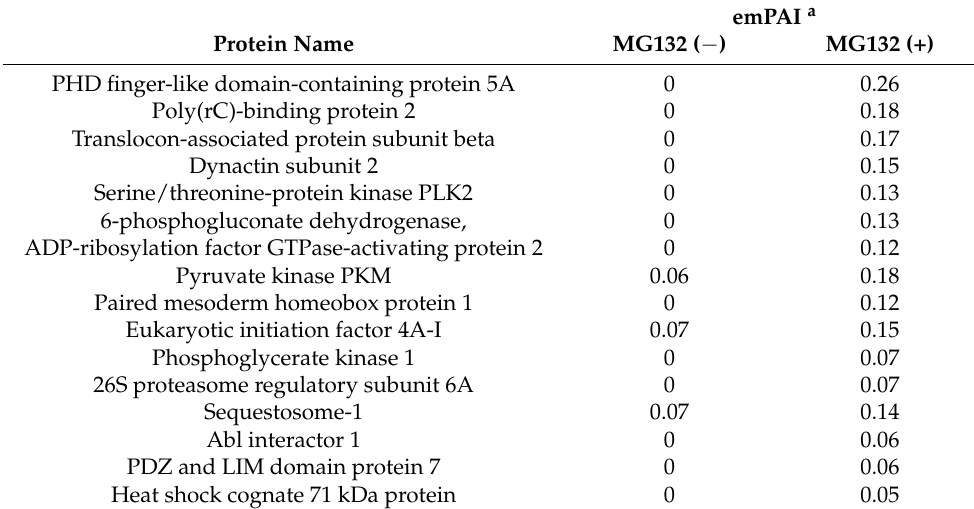
Table 1. List of candidate binding proteins for HSPB5 identified by DiDBit